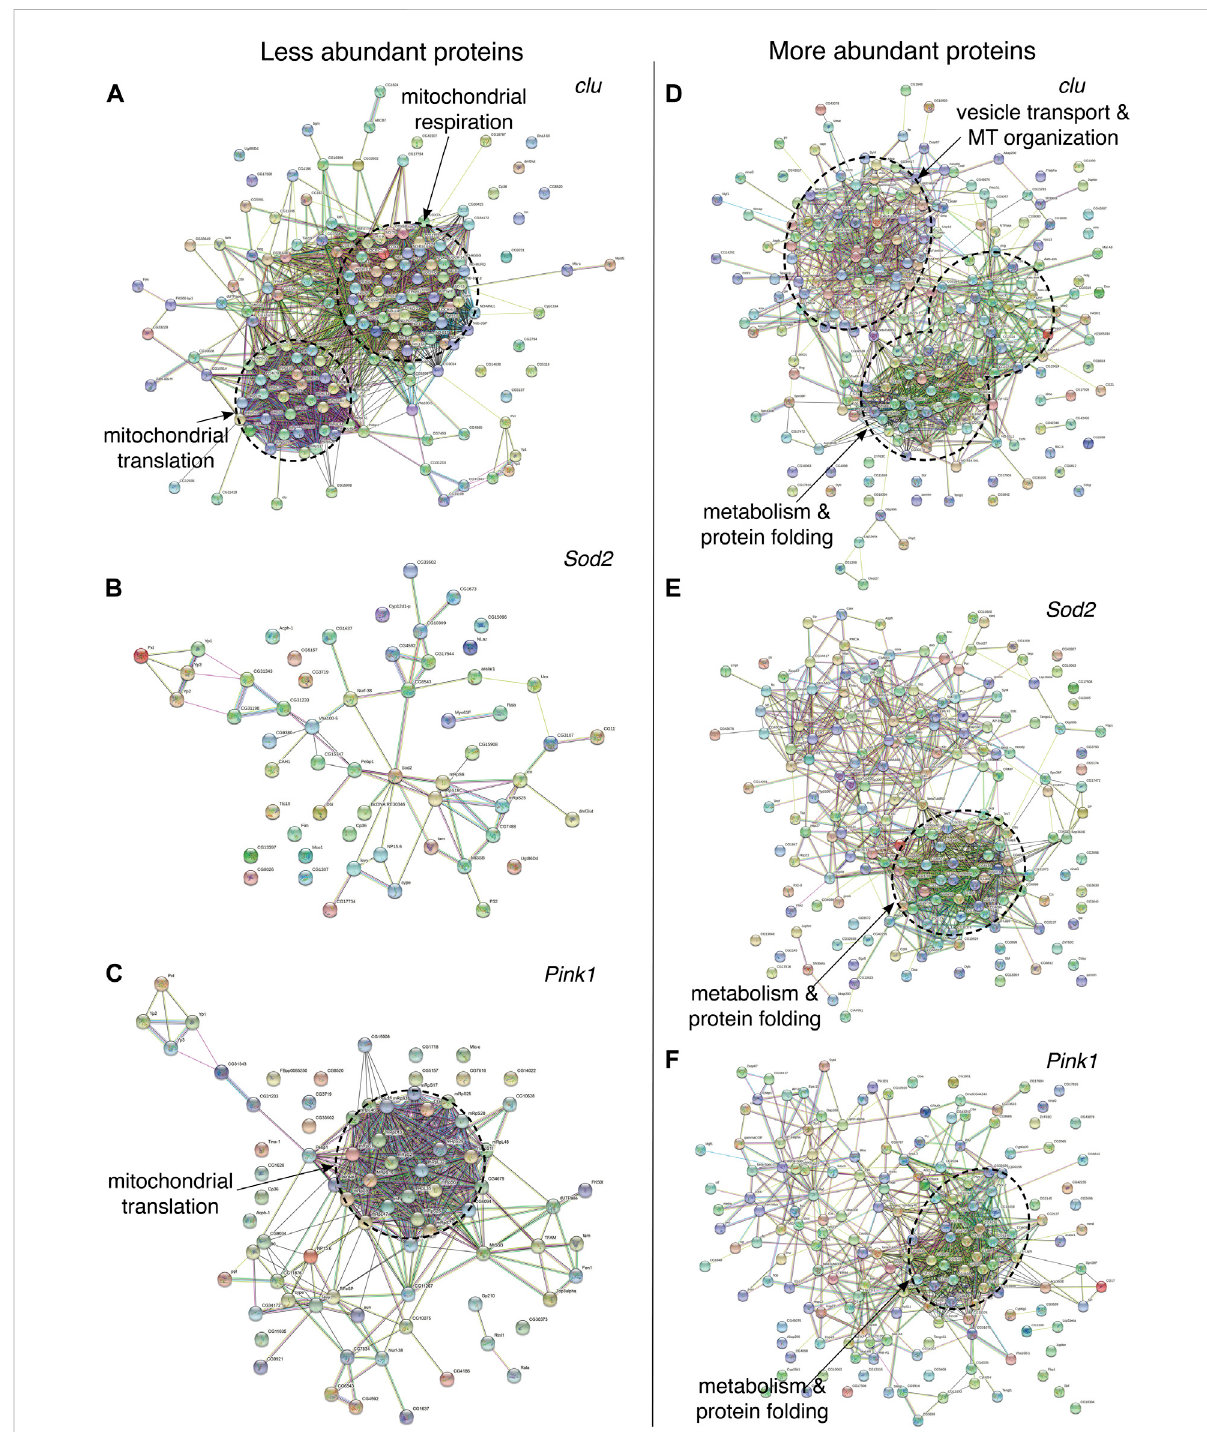
STRING protein-protein interaction (PPI) networks showing the overall clustering features of less (A – C) and more (D – F) abundant proteins in clu , Sod2 ,and Pink1 mutants.Eachofthemajorfunctionalclustersareencircledwithdashedcirclesandarelabeledbasedontheircompositionsand biological roles. High-resolution PPI networks for each panel can be found in Supplementary Figures S1 – S6 and the major candidates from each respective cluster are in Supplementary Table S6. Nodes represent proteins and edges denote interactions. The color of each node represents thenatureof interactions, e.g., known orpredicted interaction. A detailed description ofnodes and edgescan befound atSTRINGdatabase(https://